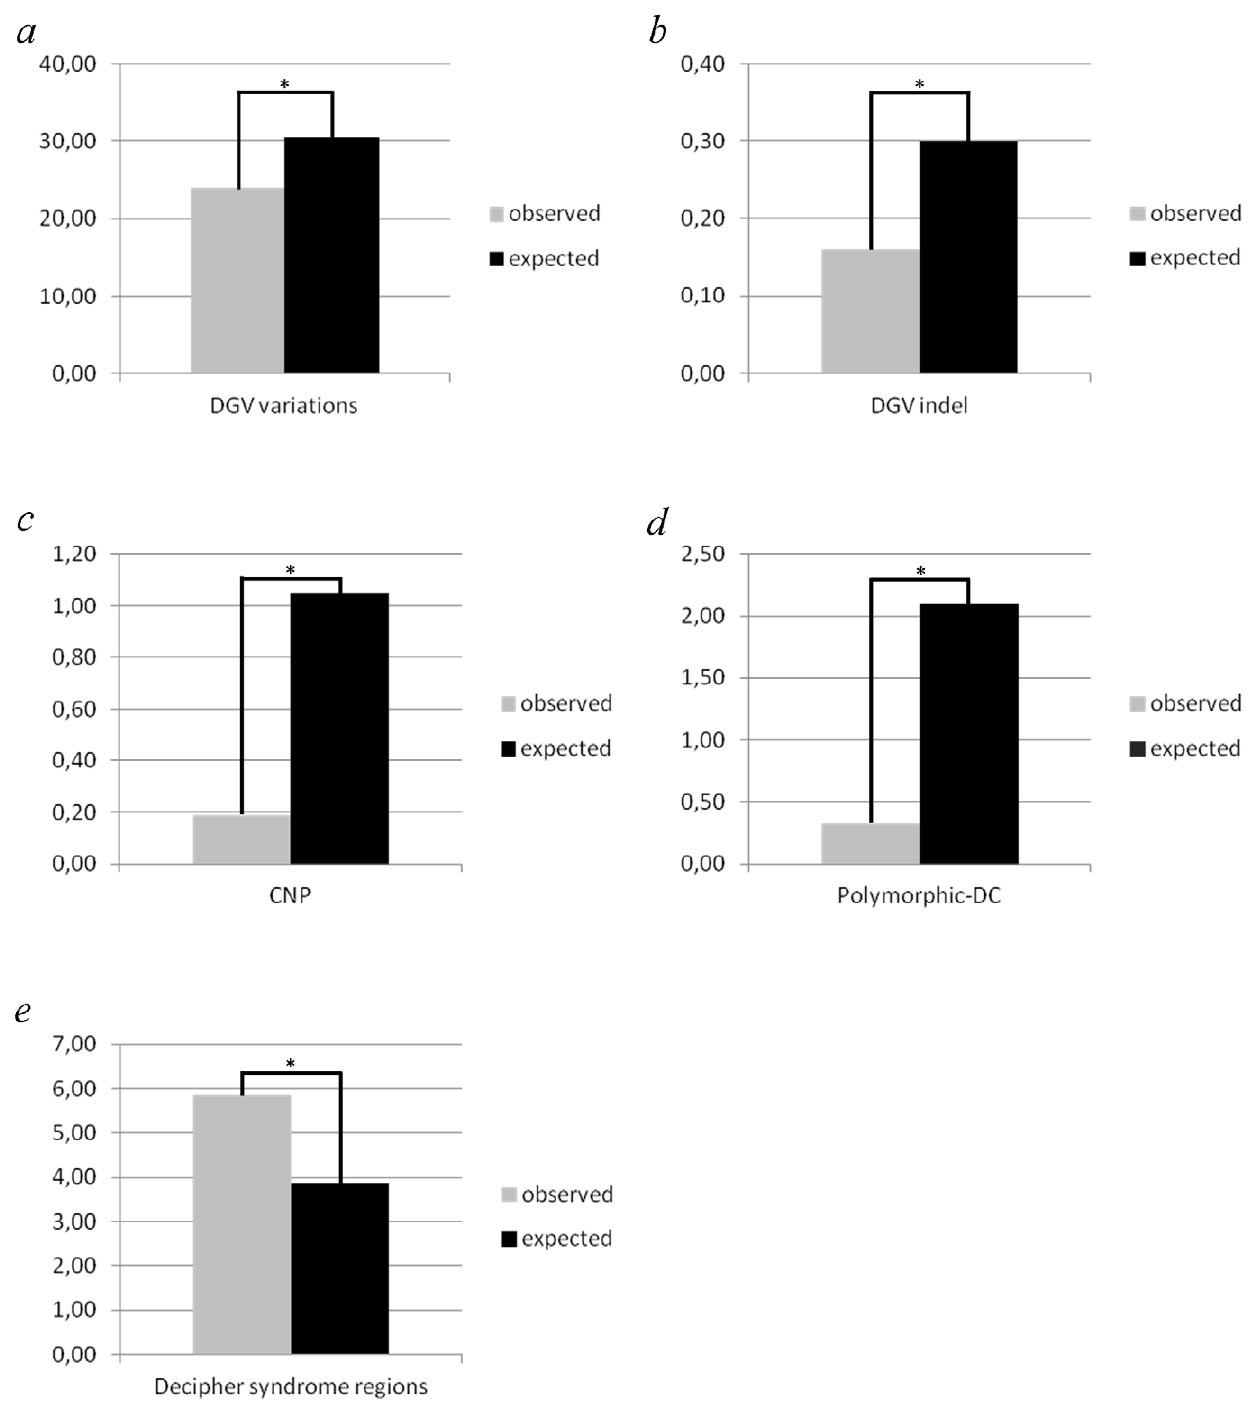
Figure 1. Comparison of observed and expected number (fraction) of VISTA enhancer loci located in different CNV regions. Bar graphs show the fractions of VISTA enhancer loci (observed numbers, grey bars) and the genome (expected numbers, black bars) covered by ‘‘DGV- deposited’’ CNV regions ( a ), ‘‘DGV-deposited’’ Indels ( b ), by two sets of polymorphic CNVs ( c and d ) and by chromosomal regions implicated in microdeletion/microduplication syndromes (Decipher syndrome regions, ( e ). All expected values were estimated based on the fraction of the genome covered by CNVs. * p-value=2.20E 2 16 as calculated on absolute numbers. doi:10.1371/journal.pone.0052264.g001 features; approximately 4.8%) was randomly filled with probes number of probes on each element depends from enhancer length, with at least 3 probes for each enhancer and an average spacing of from the commercially available Agilent Human Genome 44K 238 nt (Figure S1 d ). The residual free space on the array (2,853 array CGH.